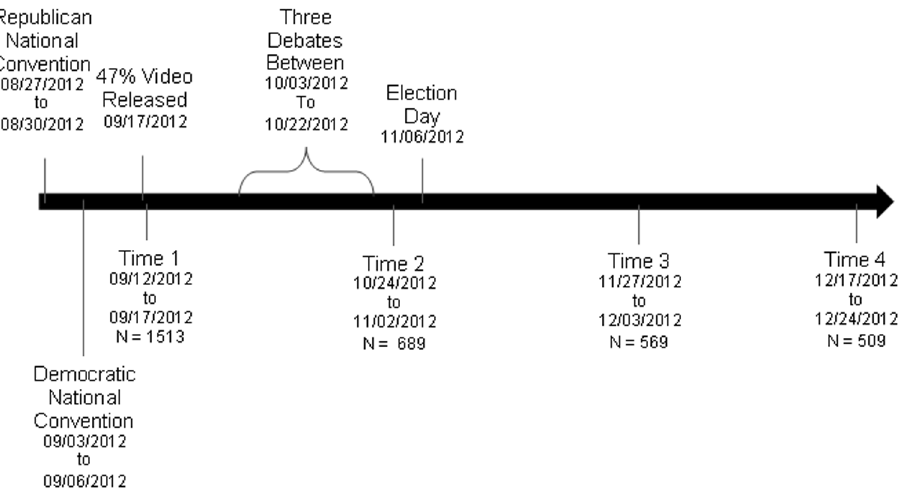
Figure 1. Timeline of the full study and major events in the 2012 U.S. presidential